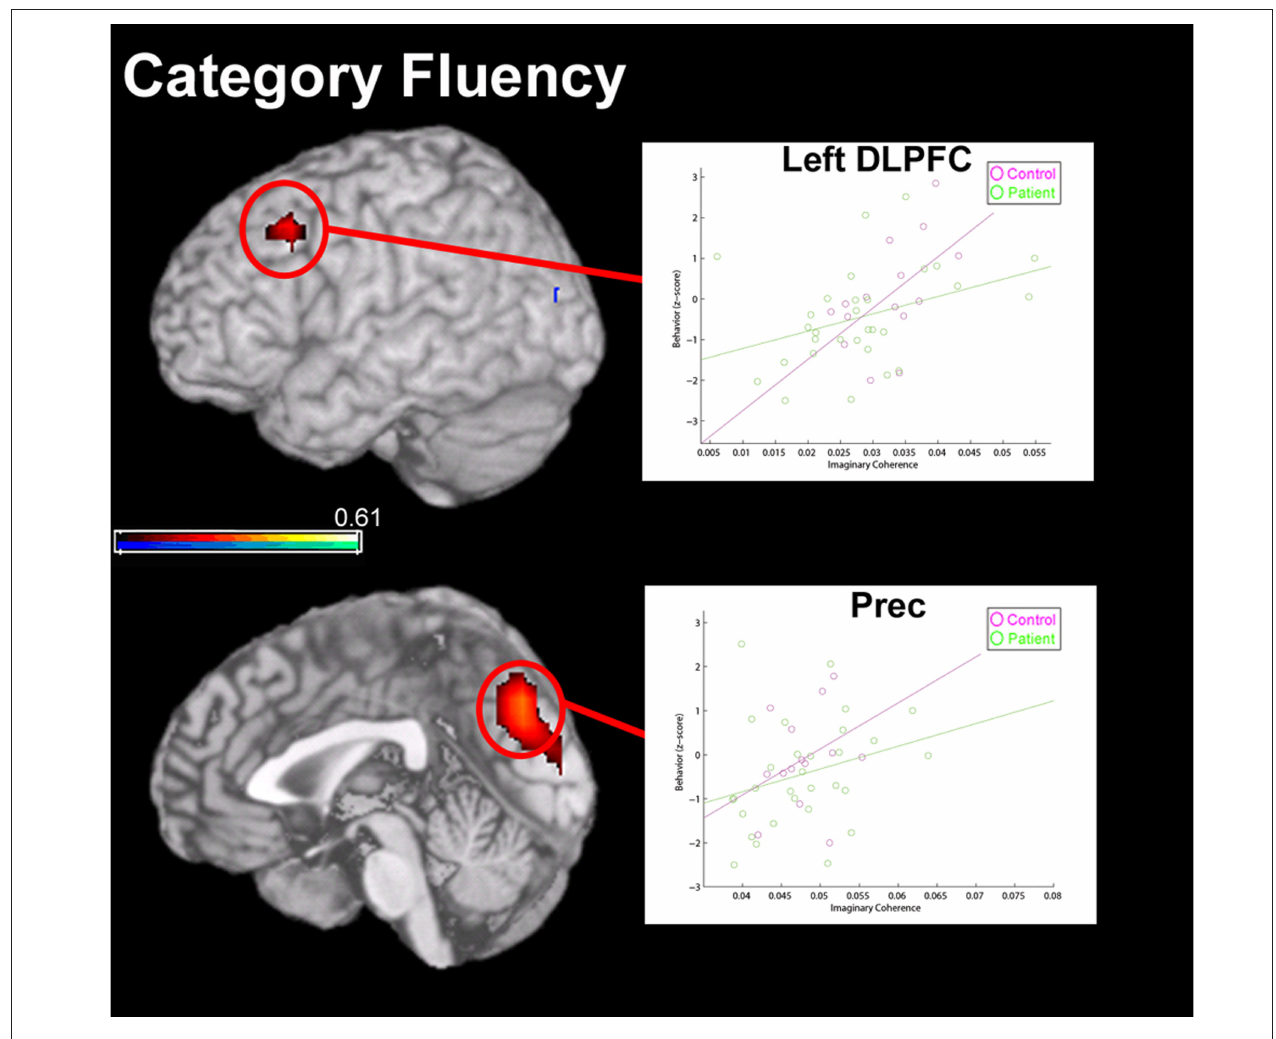
Figure  | Correlation between global functional connectivity (imaginary coherence) of Meg data at rest with performance on a measure of verbal (Category) fluency. Functional connectivity of two regions were positively correlated (overlay, in red) with performance on this task, including left dorsolateral pre-frontal cortex (DLPFC) and a region of